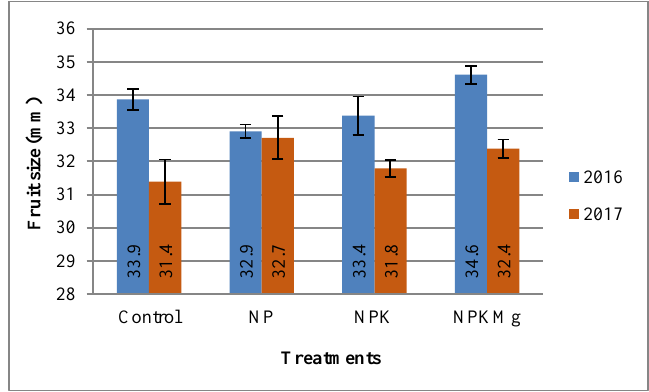
Figure 3 . Fruit size sweet cherry cultivar ‘Carmen’ (Debrecen-Pallag, 2016-2017). In both years, dry matter content was the highest with the control treatment (15.3-16.3 g/100g) ( Figure 4 ). Measured values of the fertilized trees were 12.8-13.7 in 2016 and 15.1- 15.4 in 2017. Accordingly, treatments decreased the dry matter content of the fruit, which can be related with the higher yields of the fertilized trees.